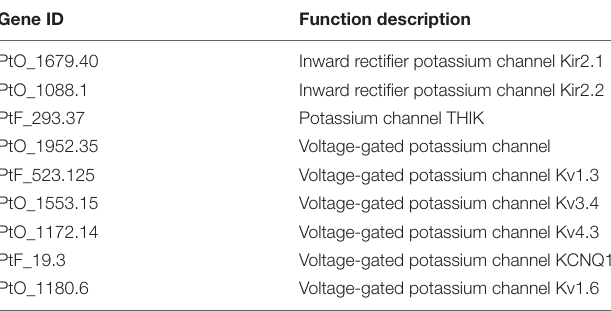
TABLE 1 | Puccinellia tenuiflora salinity-tolerant genes that were positively selected during evolutionary